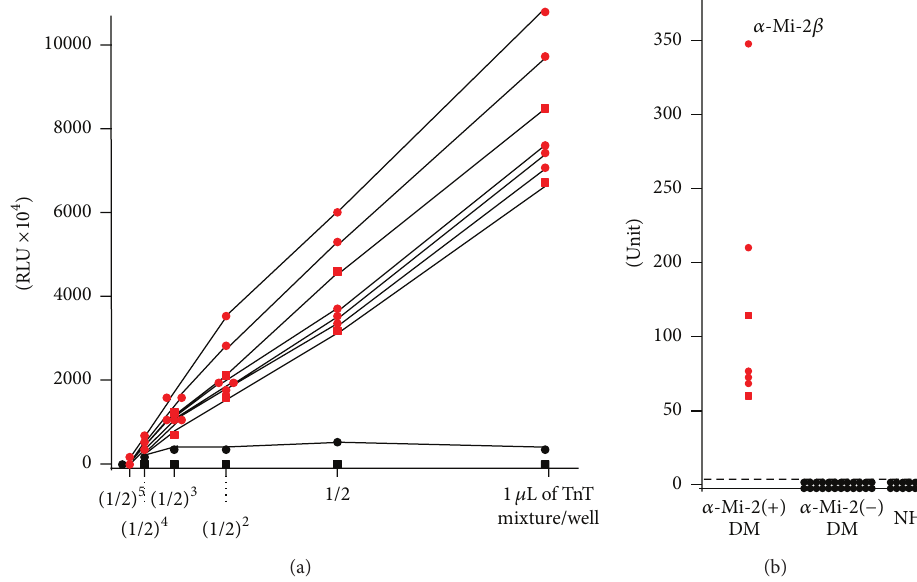
Figure 2: ELISA using biotinylated recombinant Mi-2 𝛽 protein. (a) Serial dilution of biotinylated in vitro translation and transcription product for ELISA. Red circles: anti-Mi-2 positive sera defined in our previous analysis. Red squares: newly identified anti-Mi-2 positive sera. Black circles: serum from patients with DM having high background. Black squares: healthy individual serum. Recombinant protein was diluted with T-PBS to 50 𝜇 L of the final volume per well. Serum dilution was 1:1,000. RLU = relative luminescence unit. (b) Measurement of anti-Mi-2 𝛽 antibodies in 128 serum samples from patients with DM or 20 healthy control subjects (NHS). We used the 0.5 𝜇 L/well of TnT mixture and patient serum samples diluted to 1: 1000 for measuring all samples. Antibody units were calculated from the RLU using a standard curve obtained from serial concentrations of a serum sample containing a high titer of the anti-Mi-2 𝛽 antibody. The broken line indicates the cut-off value (0.53